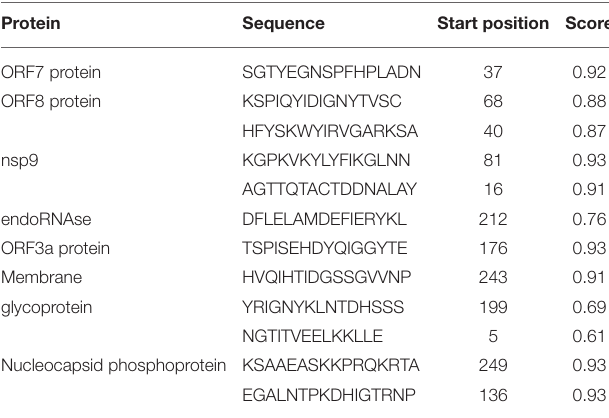
TABLE 4 | Predicted line B cell (BCL) epitopes of SARS-CoV-2 proteins utilized for construction of a multi-epitope subunit vaccine.